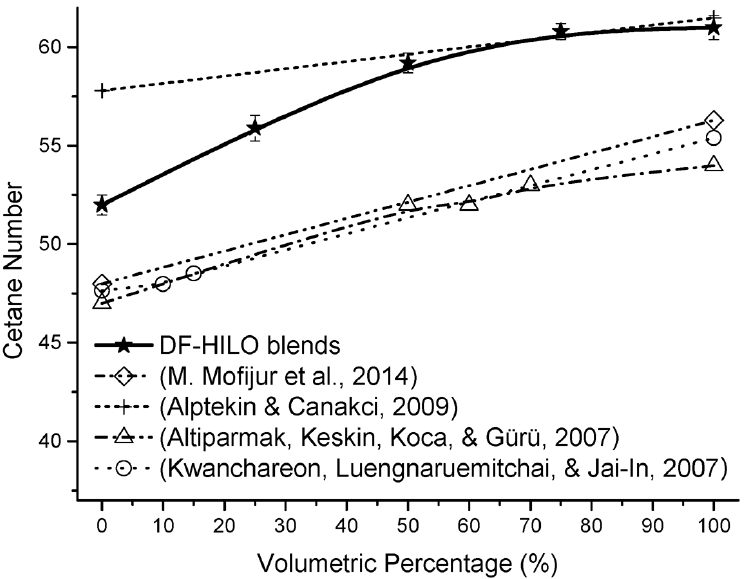
Figure 8. Variation in cetane number with volumetric percentage (vol.%) [47,49,50,60].